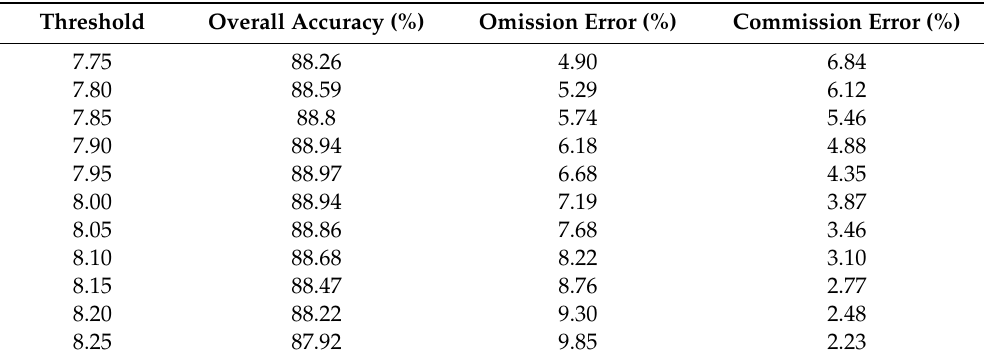
Table 2. The accuracy of area 1 with di ff erent